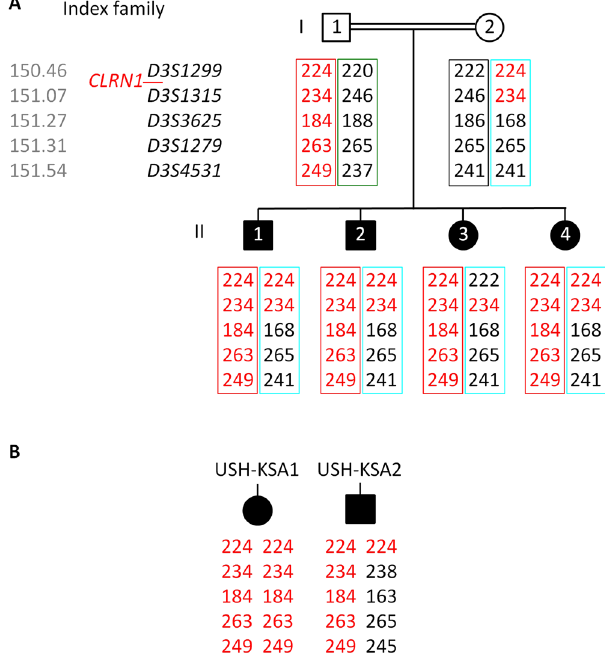
Figure 5. Genotyping of polymorphic microsatellite markers from the CLRN1 ( USH3A ) locus on chromosome 3q25.1 in ( A ) the index family and ( B ) the two additional Saudi patients (USH-KSA1 and USH-KSA2) who also carry the c.254–649T > G CLRN1 mutation in homozygous state. Grey numbers indicate the marker positions in Mb on chromosome 3 (according to hg38). Numbers indicate the PCR product size obtained with the primer pairs given in the UCSC Genome Browser. Only D3S1315 localizes within one of the two HBD regions that has been mapped in the index family. D3S1299 is located centromeric of that HBD region while D3S3625 , D3S1279 and D3S4531 are telomeric of that region. The putative original c.254–649T > G-associated haplotype (red) is preserved on the paternal allele in the index family (paternal and maternal haplotypes are indicated by boxes of different colors), on one allele of patient USH-KSA2, and on both alleles of patient